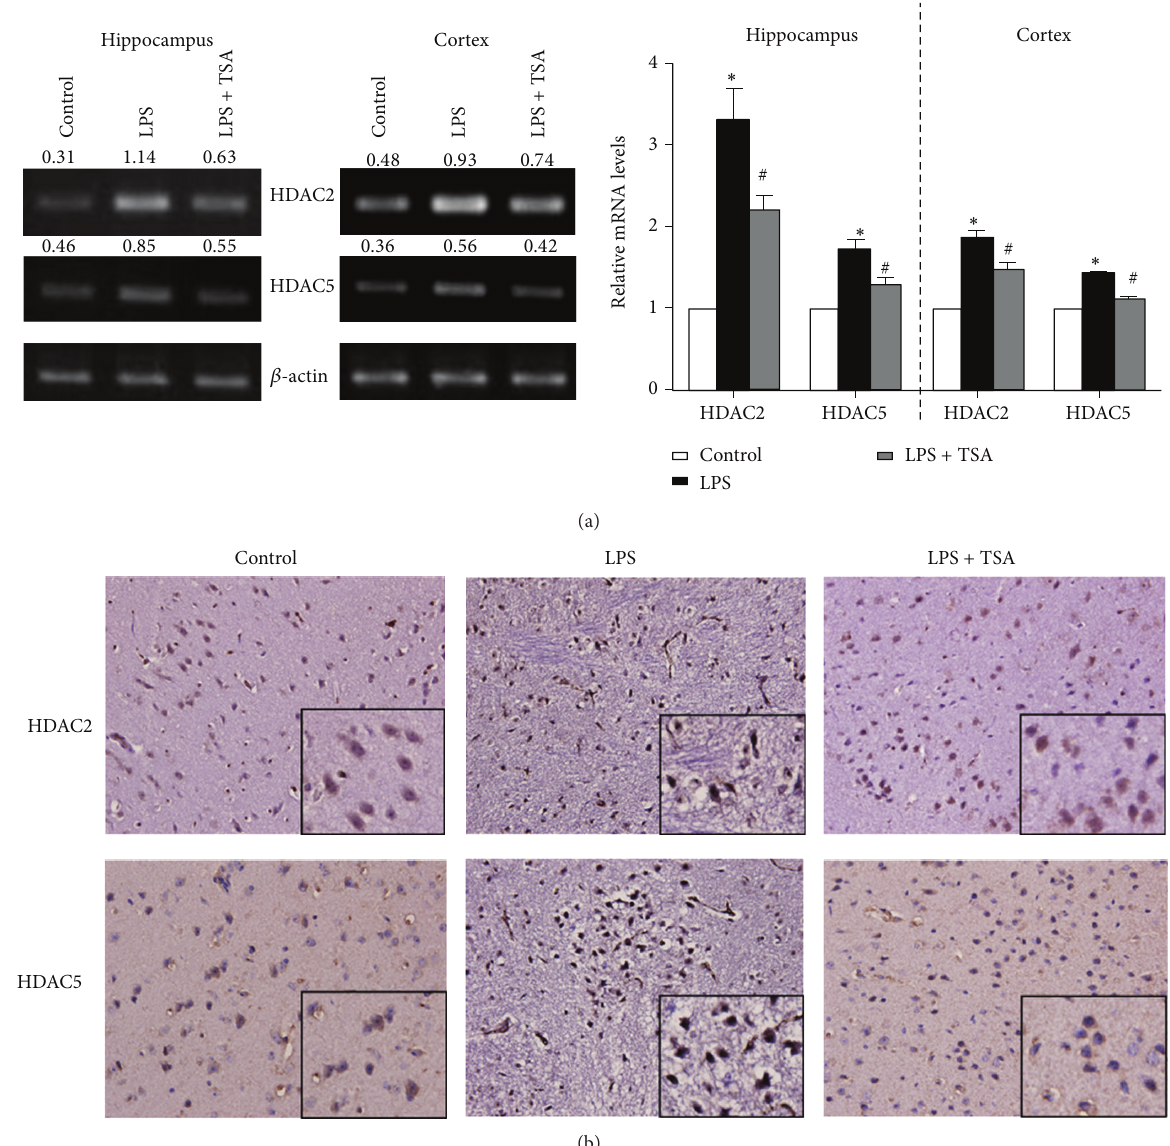
Figure 3: TSA attenuated LPS-induced HDAC2 and HDAC5 expression in the hippocampus and cortex of mice. Mice were pretreated with saline (Controls) or TSA (0.3 mg/kg) for 1h and then intraperitoneally challenged with saline or E. coli LPS (1mg/kg) ( 𝑛 = 6 in each group). (a) HDAC2 and HDAC5 mRNA were detected using RT-PCR. The right panel shows the quantification of mRNA expression from six independent experiments. ∗ 𝑃 < 0.05 compared with the Control group; # 𝑃 < 0.05 compared with the LPS-only group. (b) Immunohistochemical staining showed that HDAC2 and HDAC5 expression were increased in the cortex of mice after being LPS challenged, which were reduced in LPS + TSA